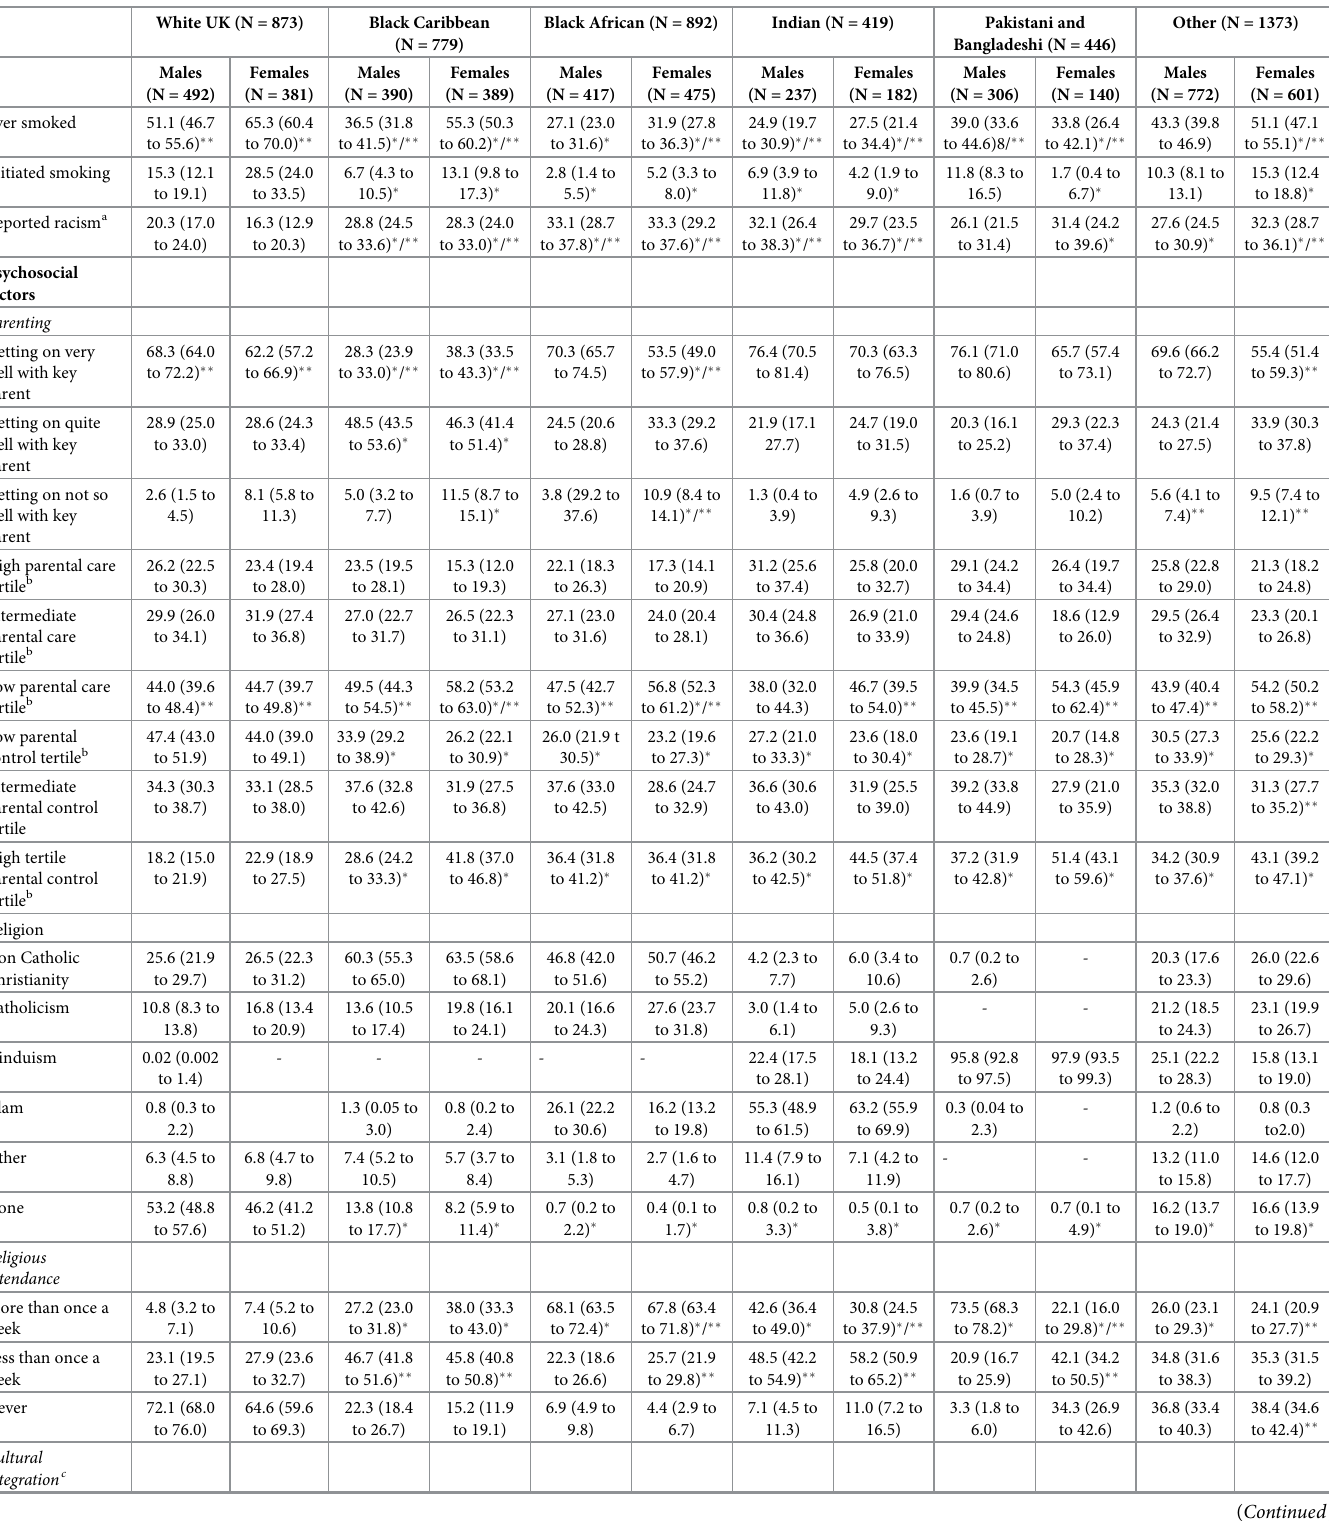
Table 3. Sample profile at 14-16y by gender and ethnicity. The Determinants of Adolescent (now Adult) Social well-being and Health study. White UK (N = 873) Black Caribbean Black African (N = 892) Indian (N = 419) Pakistani and (N = 779) Bangladeshi (N =